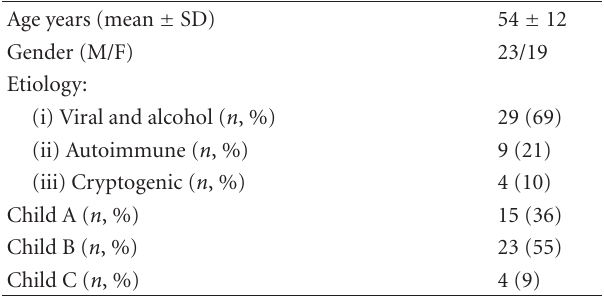
Table 1: Demographic and clinical data of examined patients with liver cirrhosis ( n = 42).